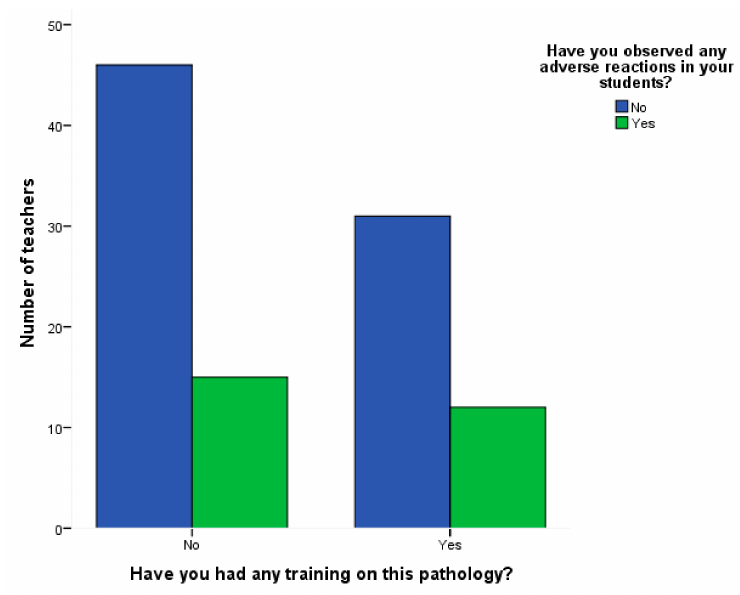
Figure 3. Observed adverse drug reactions by teachers with and without training on